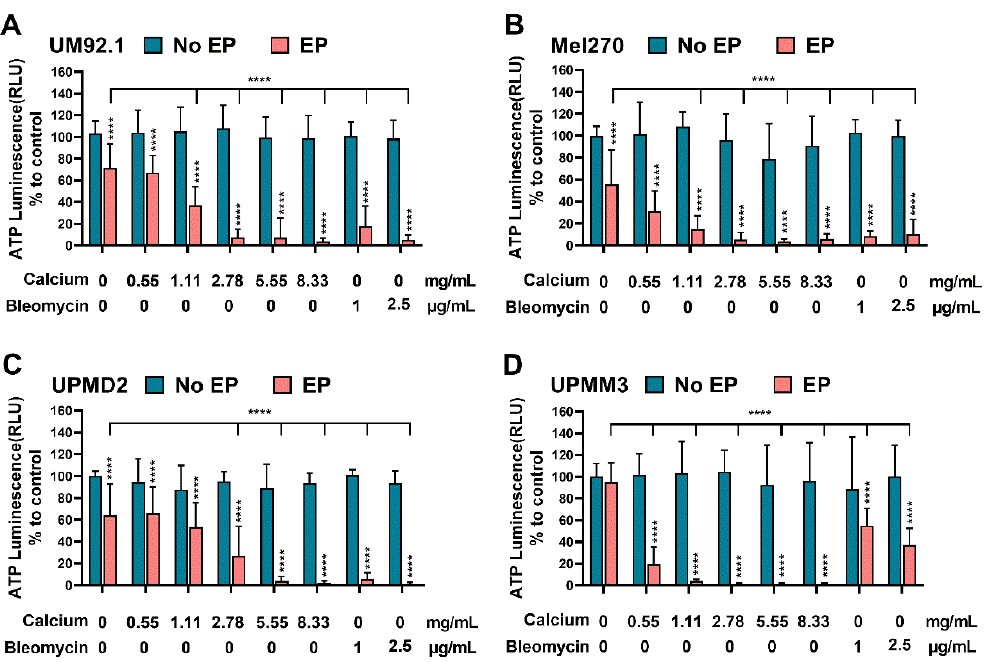
Figure 2. Effect of CaEP and ECT on UM and UPM tumor spheroid ATP level. ( A ) UM92.1 spheroids, ( B ) Mel270 spheroids, ( C ) UPMD2 spheroids, and ( D ) UPMM3 spheroids were incubated with different concentrations of calcium chloride (0.55, 1.11, 2.78, 5.55, or 8.33 mg/mL) or bleomycin (1 µ g/mL or 2.5 µ g/mL) and electroporated (1000 V/cm pulse strength, 100 µ s pulse duration and 5 Hz repetition frequency; EP group). Untreated cells, calcium chloride alone, bleomycin alone (no EP